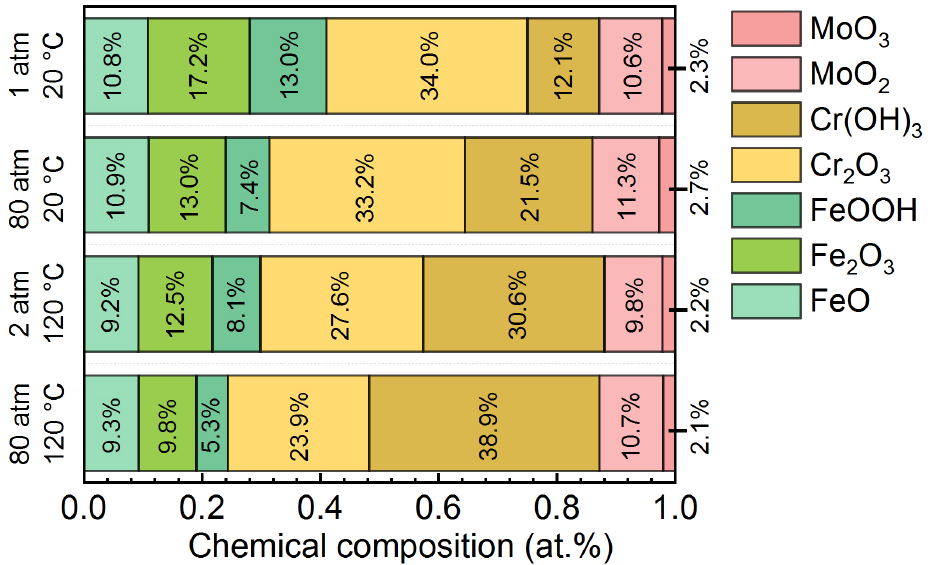
Figure 7. Chemical compositions of the passive films formed on the AMCs under different tempera- tures and pressures.